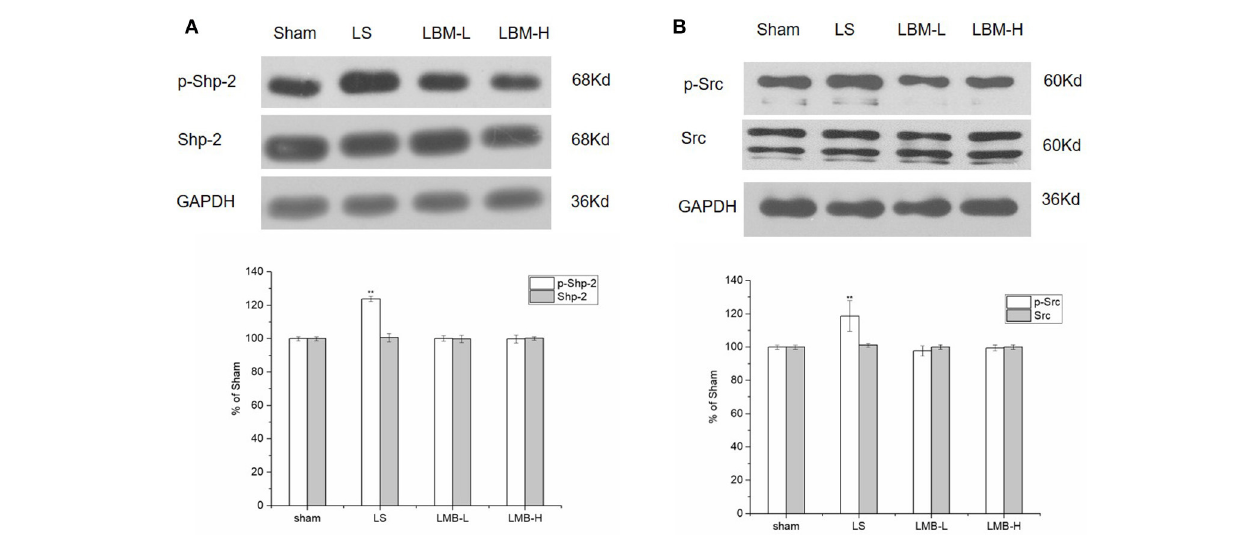
FIGURE 4 | Changes in expression of phospho-Shp-2, Shp-2 (A) , and phospho -Src, Src (B) after either intermittent or continuous L-dopa administration in 6-OHDA-lesioned striatum for 21 days. (A) The phosphorylated Shp-2 level at Tyr542 increased significantly in the LS group compared with the sham, LBM-L, and LBM-H group ( p < 0.01). No significant difference was found in the phosphorylation level of Shp-2 among the LBM-L and LBM-H and sham group ( p > 0.05). The total amount of Shp-2 remained stable in all groups ( p > 0.05). (B) Phosphorylated Src level at Ser17 increased significantly in LS group compared with the sham, LBM-L and LBM-H group ( p < 0.01). No significant difference was found in the phosphorylation level of Src among the LBM-L and LBM-H and sham group ( p > 0.05). The total amount of Src remained unchanged in all groups ( p > 0.05). All above protein levels expressed relative to GAPDH levels. The data are expressed in terms of means ± SD and expressed as a percentage of the sham group. ** p < 0.01 vs. sham group ( n = 5 per